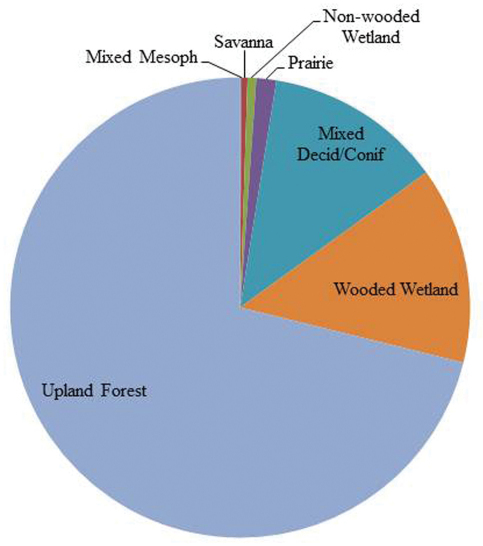
 Pre-European settlement vegetation percentage cover for Ohio (from Ohio Department of Natural Resources 2003).